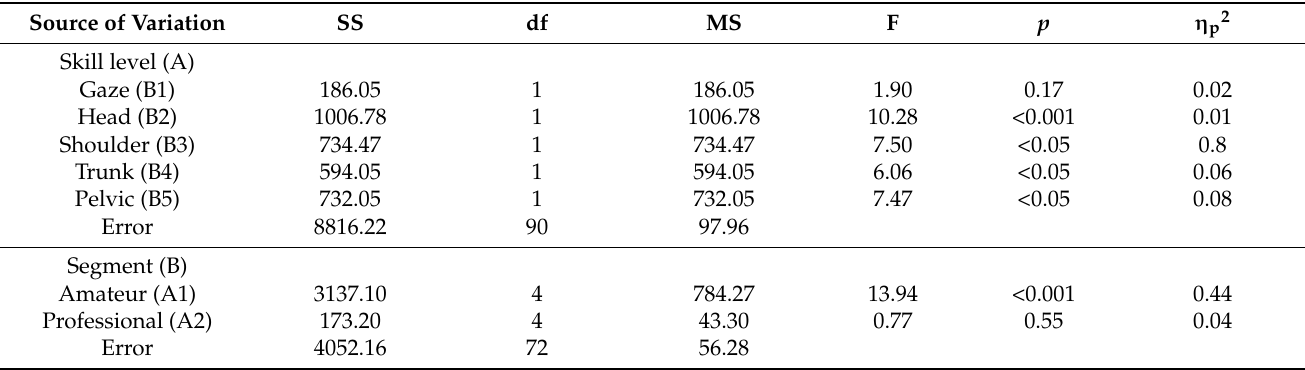
Table 3. Simple main effects on the group and